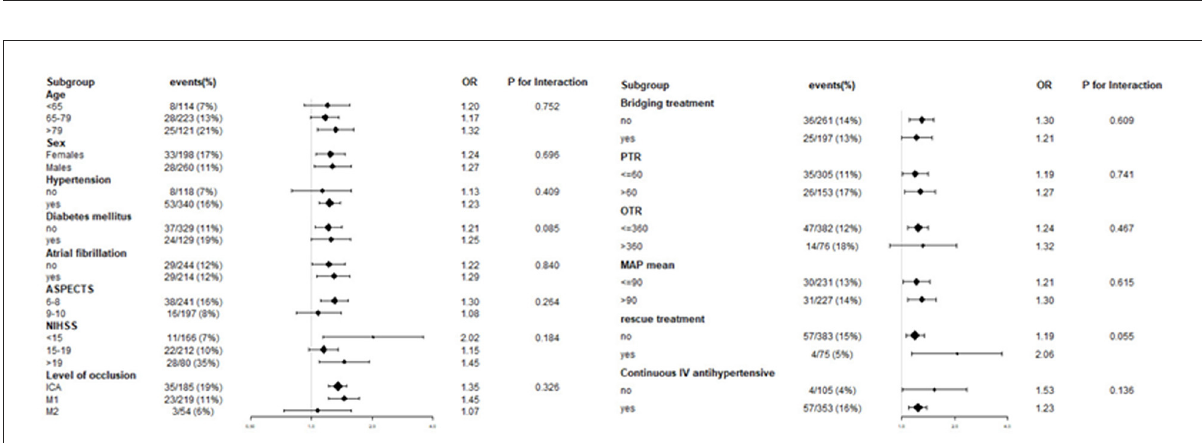
FIGURE6 Interaction test for the effect of MAP SD on 30-day mortality in different subgroups after adjusting for confounding factors. The above model adjusted for confounding factors in Table 2 (Model II). In each case, the model is not adjusted for the stratification variable.